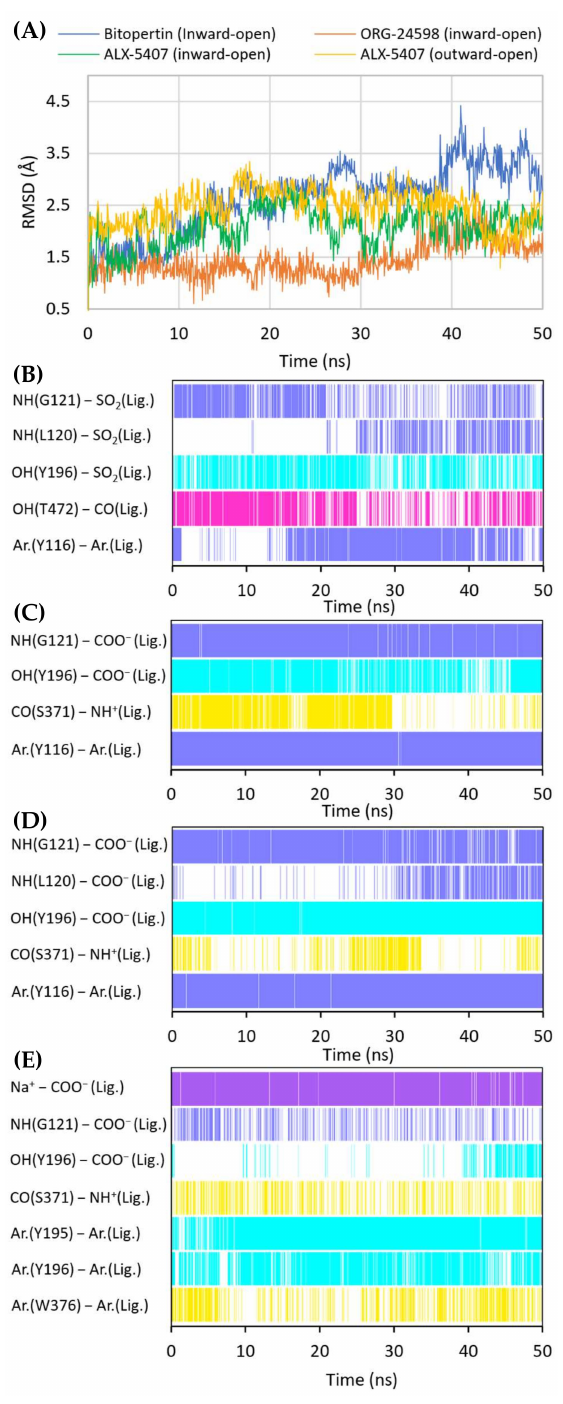
Figure 6. RMSD changes observed for the ligands in a complex with GlyT-1 in the course of MD simulations ( A ). Stability of the key interactions between the ligand and the transporter during MD simulations for bitopertin ( B ), ORG-24598 ( C ), and ALX-5407 ( D ) in a complex with GlyT-1 in the inward-open state and for ALX-5407 in a complex with GlyT-1 in the outward-open state ( E ). The presence of interactions in a particular MD frame is marked in